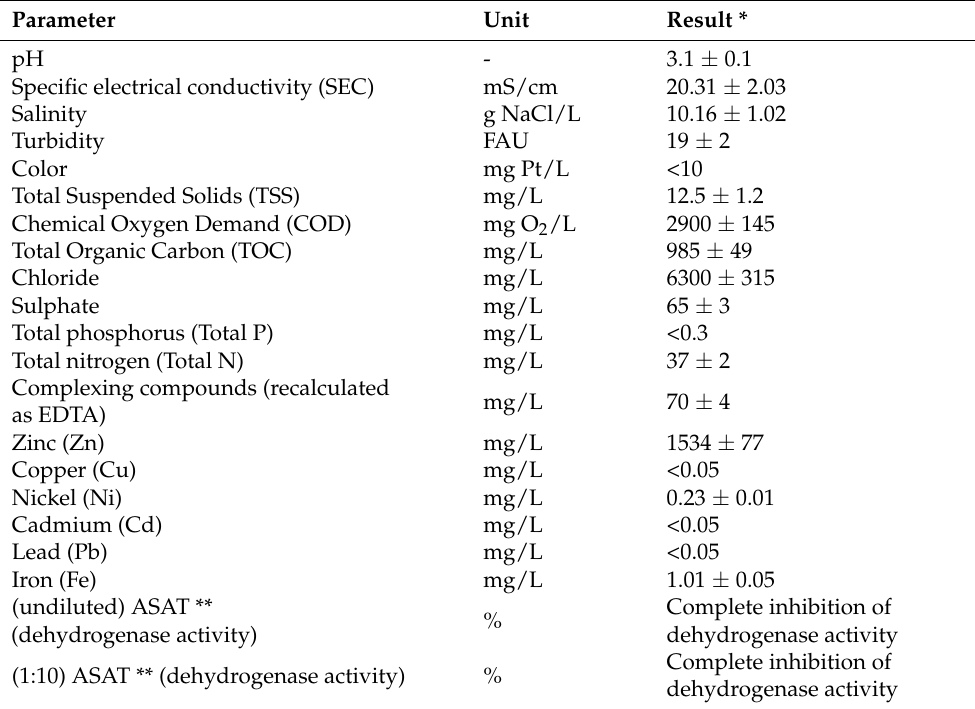
Table 2. Selected physicochemical and toxicological parameters of concentrated galvanic wastewater.